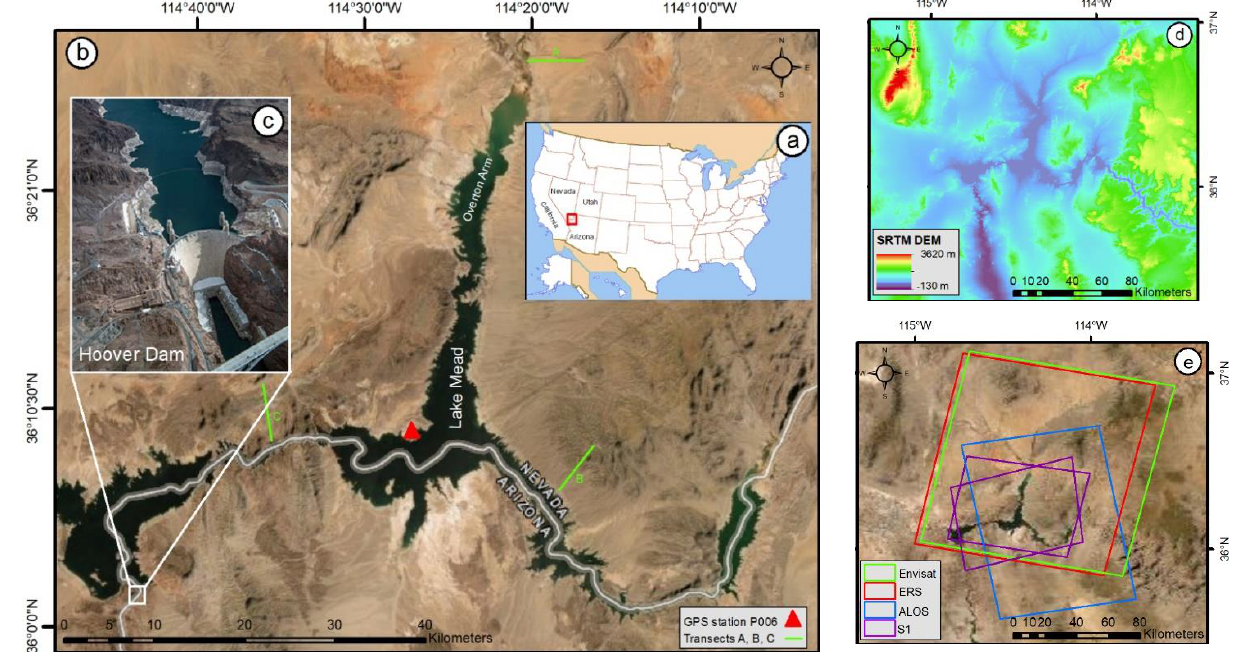
Figure 1. Location of Lake Mead ( a ) in the United States, ( b ) satellite view of Lake Mead and location of the GPS station P006 (red triangle), ( c ) zoomed view of the Hoover Dam (photo source: [54]), ( d ) Shuttle Radar Topography Mission (SRTM) Digital Elevation Model (DEM) of the area of interest with 30−m spatial resolution, and ( e ) extent of the four different SAR scenes used in this study over the Lake Mead area (i.e., ERS1/2−red, Envisat−green, ALOS-blue, and S1−purple), shown over a Google Earth image. The standard full extent of the Envisat, ERS, and ALOS data, and the extent of three selected bursts of S1 (ascending and descending) are displayed in the figure.